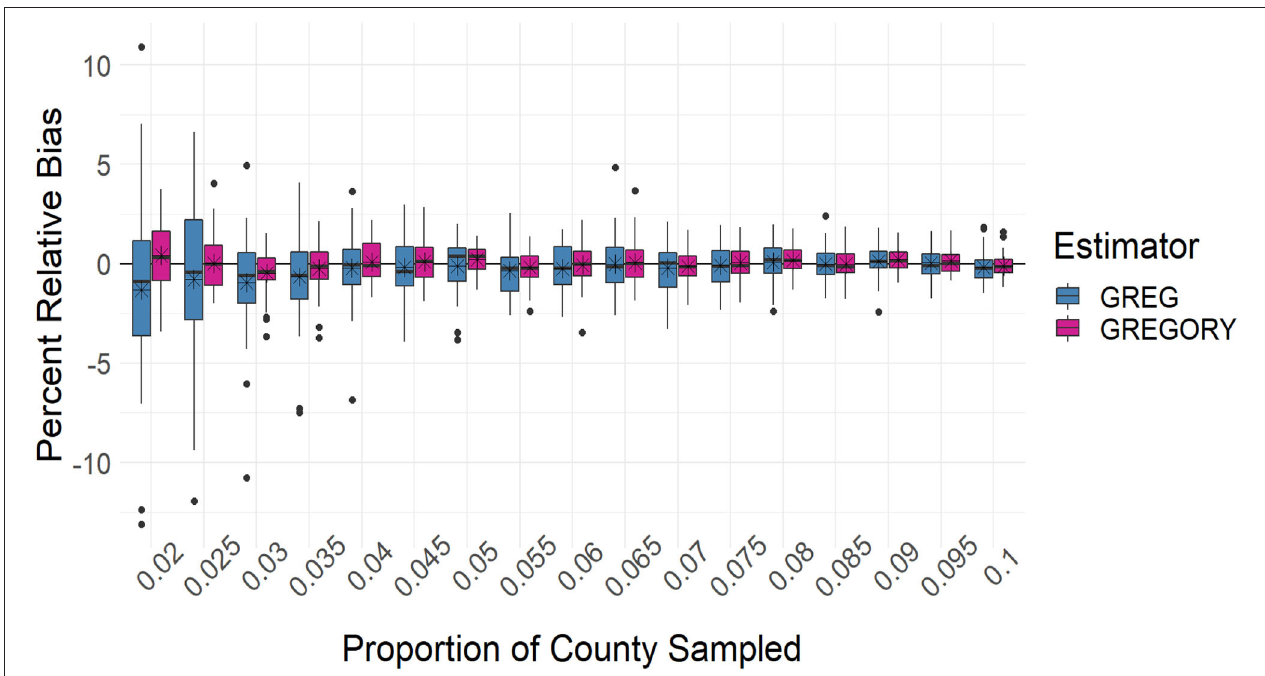
FIGURE 6 | Boxplots of the percent relative bias of the county estimates of average trees per acre across the sampling intensities. The average percent relative bias is denoted by the